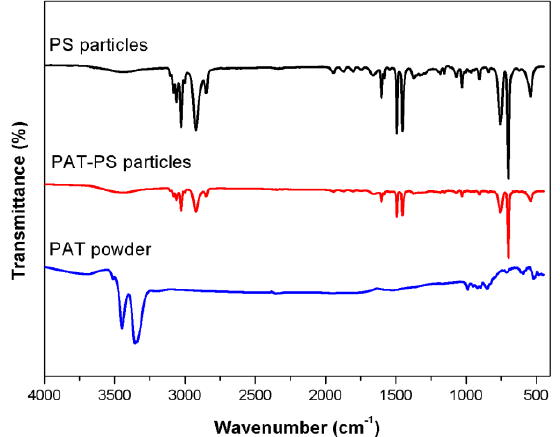
Figure 10. FTIR spectra of PAT (prepared at an oxidant/monomer ratio of 0.5), PS, and typical PAT-PS particles (run 4). Note the relatively weak bands due to the PAT component in the spectrum of PAT-PS particles relative to the spectrum of PS particles.